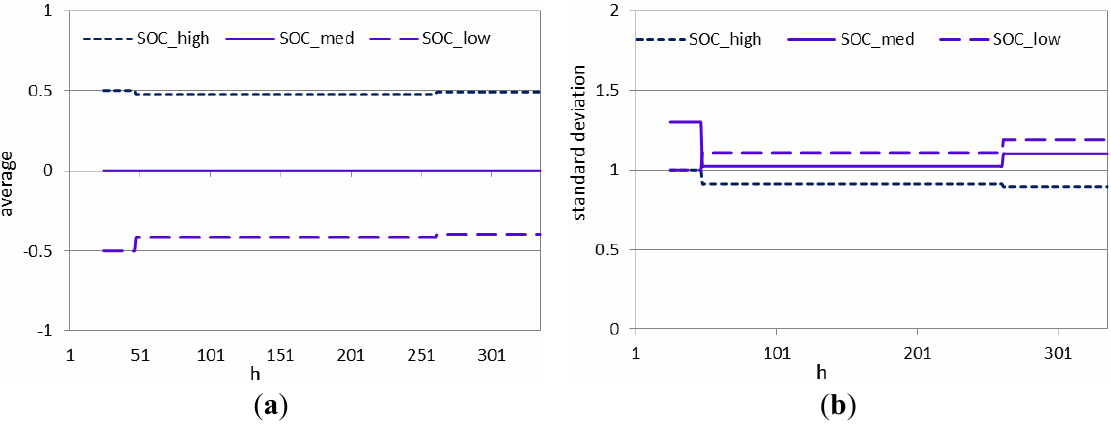
Figure 18. ( a ) Average parameters μ behaviour for SOC_low, SOC_med and SOC_high MFs and ( b ) standard deviation σ parameters courses for SOC_low, SOC_med and SOC_high MFs.